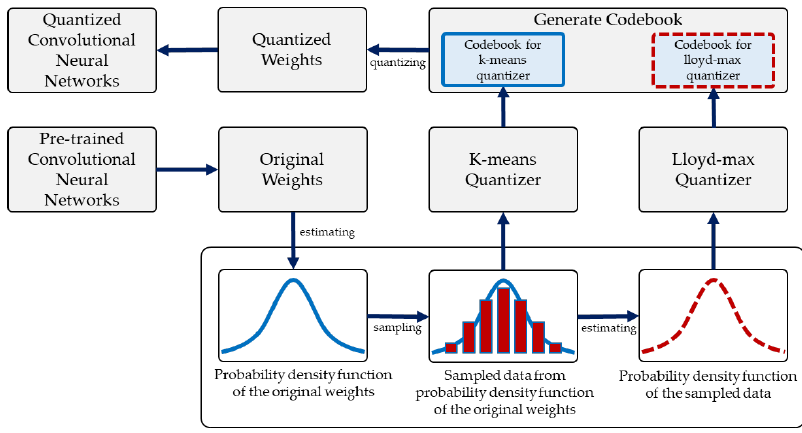
Figure 2. Overview of weights quantization using the kernel density estimation.